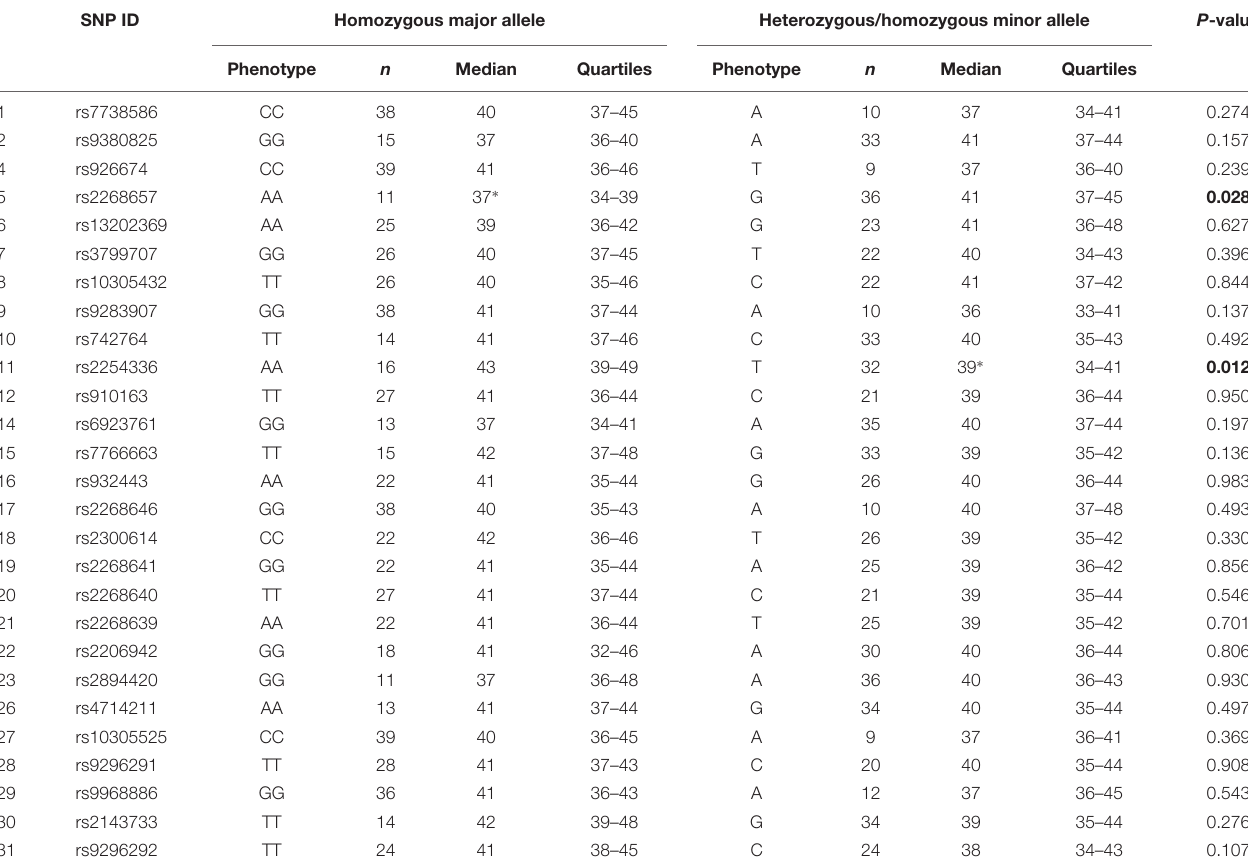
TABLE 5 | Gastric emptying T lag results according to